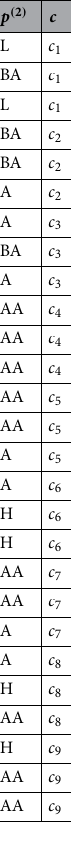
Table 1. Knowledge base according to equation c = f c